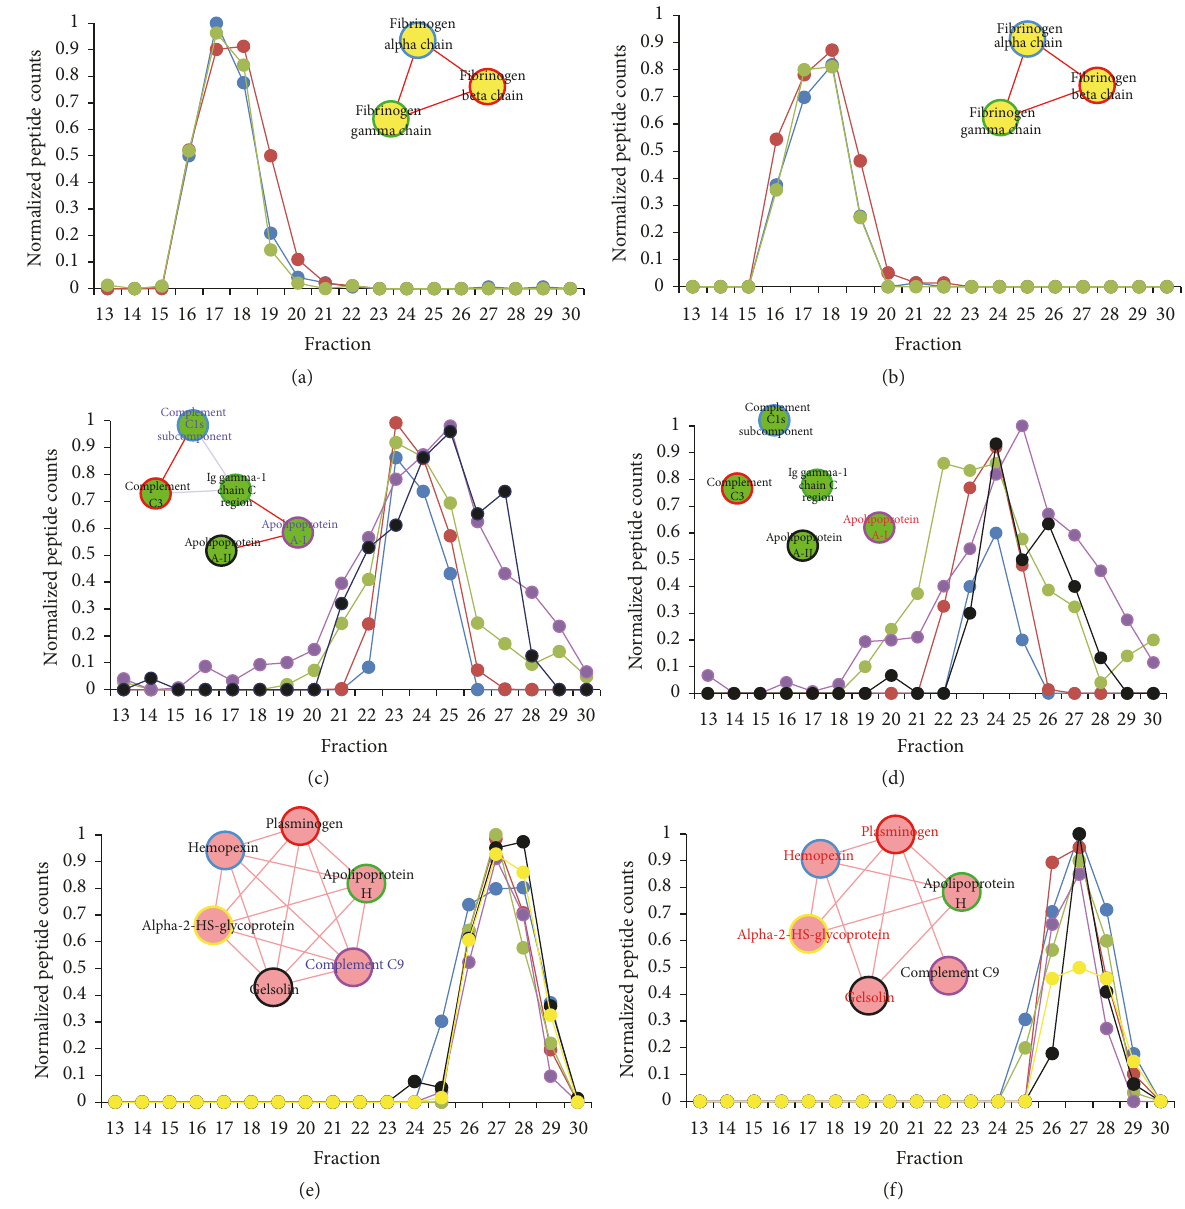
Figure 6: Comigration patterns of the proteins residing on the same subspecies with at least two PWV-correlated proteins in the lean (a, c, e) and the T2D (b, d, f) groups . Data are mean normalized peptide counts. Colors of distribution patterns are matched to the colors of node outlines. (a-b) Control: comigration pattern of fibrinogen 𝛼 / 𝛽 / Υ chains (on the same particle) shows no difference between lean and T2D. (c-d) Cluster 1: apolipoprotein A-I, apolipoprotein A-II, Ig gamma-1 chain C region, complement C3, and complement C1s subcomponent. (e-f) Cluster 2: hemopexin, plasminogen, apolipoprotein H, complement C9, gelsolin, and alpha-2-HS glycoprotein.